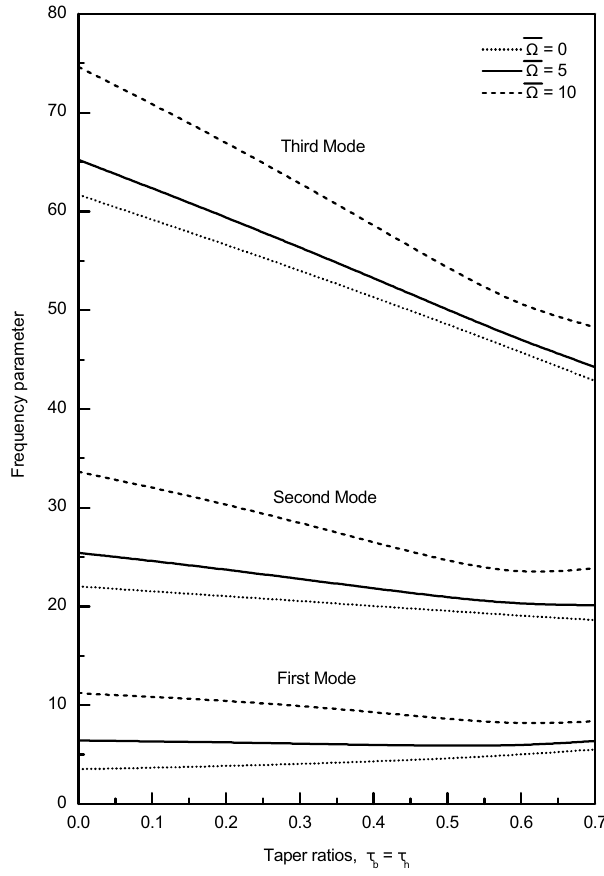
Fig. 2. Effect of equal taper ratios on the frequency parameters of rotating Euler-Bernoulli beam with ¯ R = 0 .